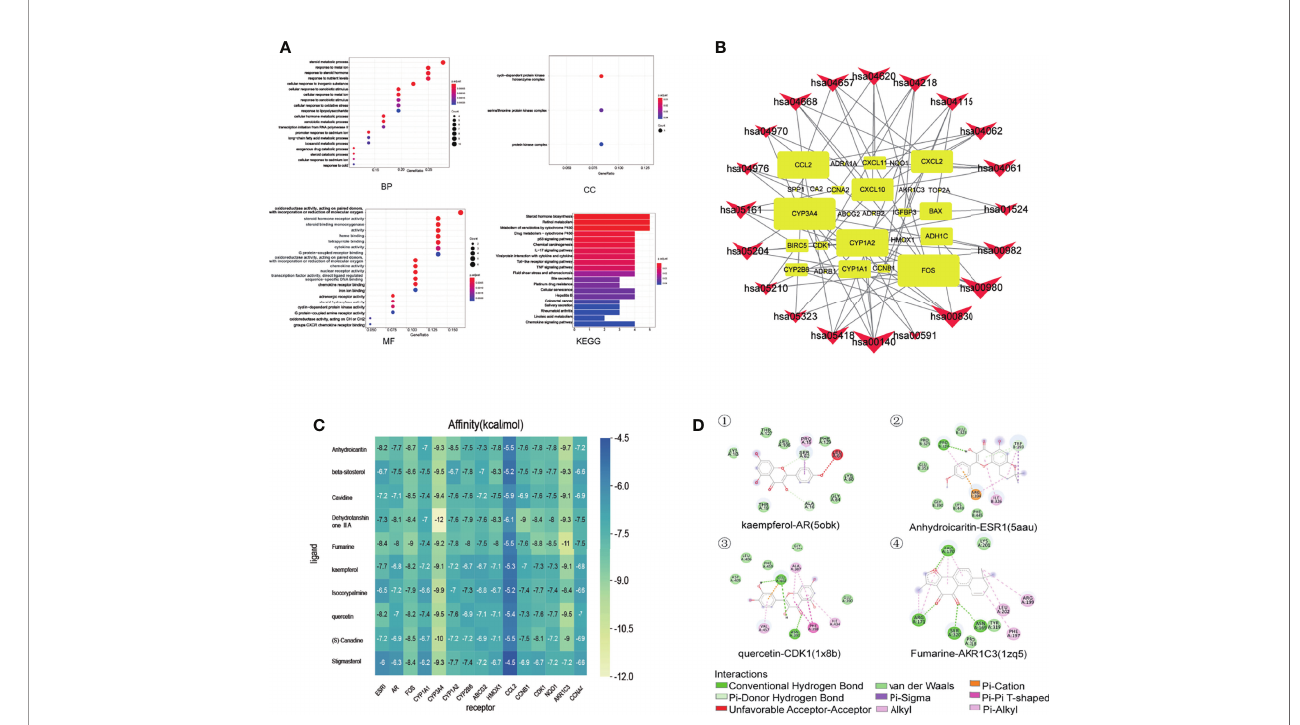
FIGURE 3 | GO biological process and KEGG pathway enrichment analysis, and molecular docking of core compounds and core target genes. (A) The abscissa of the GO biological process bubble chart represents the proportion of genes, and the ordinate represents the names of enriched biological processes, cell components, and molecular functions, respectively. The bubble size represents the proportion of genes on each biological process. The larger the bubble, the more genes are enriched. The horizontal axis of the KEGG pathway bubble chart represents the proportion of the pathway in the total pathway, and the vertical axis represents the pathway name. The bar length represents the proportion of genes on each pathway. The longer the bar, the more genes are enriched. The color represents the degree of enrichment. And the closer the color is to red, the more signi fi cant the enrichment is. (B) KEGG relationship network construction. In the KEGG relationship network diagram, the red arrows represent pathways, the yellow rectangles represent genes, and the links represent the relationship between pathways and genes. The larger the red arrow, the greater the number of genes enriched in the pathway. Similarly, the larger the yellow rectangle, the more pathways connected to the gene. (C) The abscissa represents the core gene, and the ordinate represents the core compound. The numbers in the box represent the docking af fi nity score. The grading color scale ranges from blue to yellow. The closer the color is to yellow, the lower the af fi nity score is and the stronger the binding is. (D) The fi gure is the two-dimensional structure diagram of ligand and receptor interaction. Different color represents different